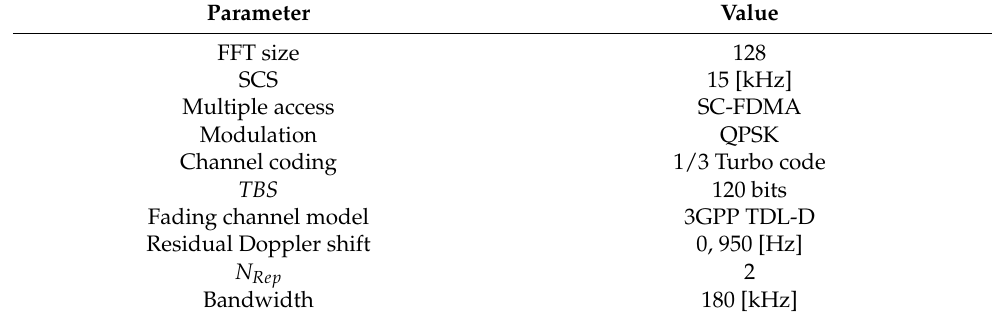
Table 5. Link-level simulation parameters.